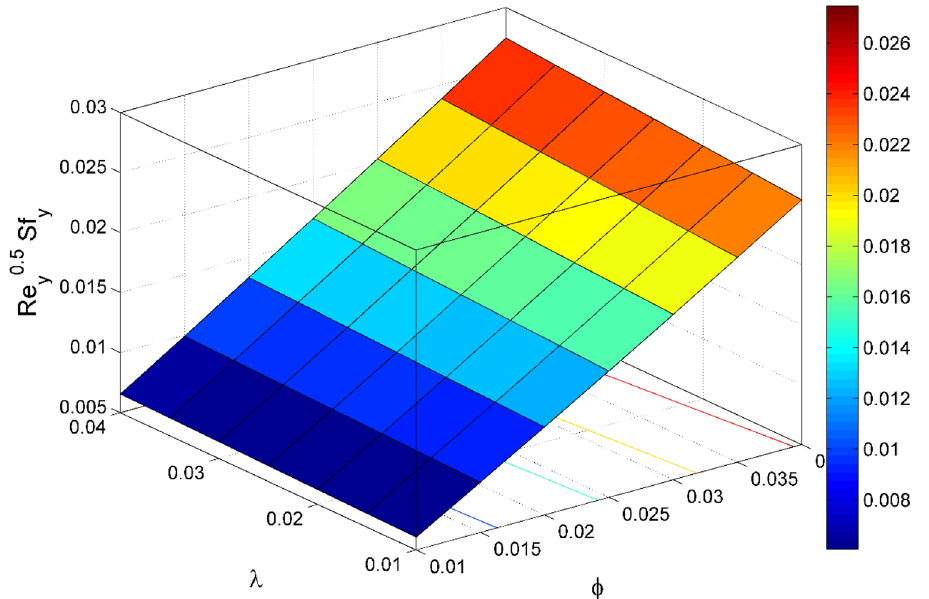
Figure 18. Re 0.5 y Sf y behavior for the variation of nanoparticles volume fraction φ and stretching ratio (cid:31)